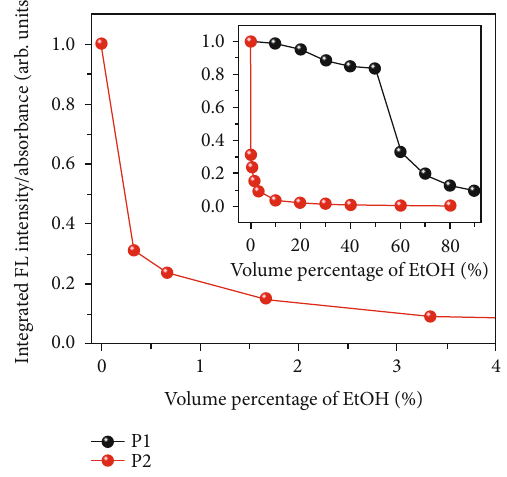
Figure 12: Plots of normalized, absorbance-corrected, integrated fl uorescence intensity (excited at the corresponding absorption maximum) of P1 and P2 as dilute solutions in mixed hexane/EtOH solvent as a function of volume percentage of EtOH. Note that P2 has poor solubility in hexane, and the upper, clear portion of a saturated P2 solution in hexane was collected and used as the stock